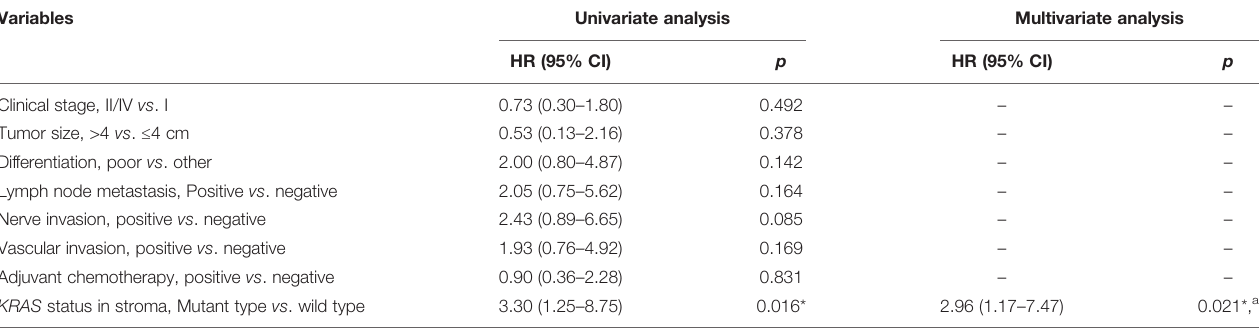
TABLE 2 | Univariate and multivariate Cox analyses for risk factors of